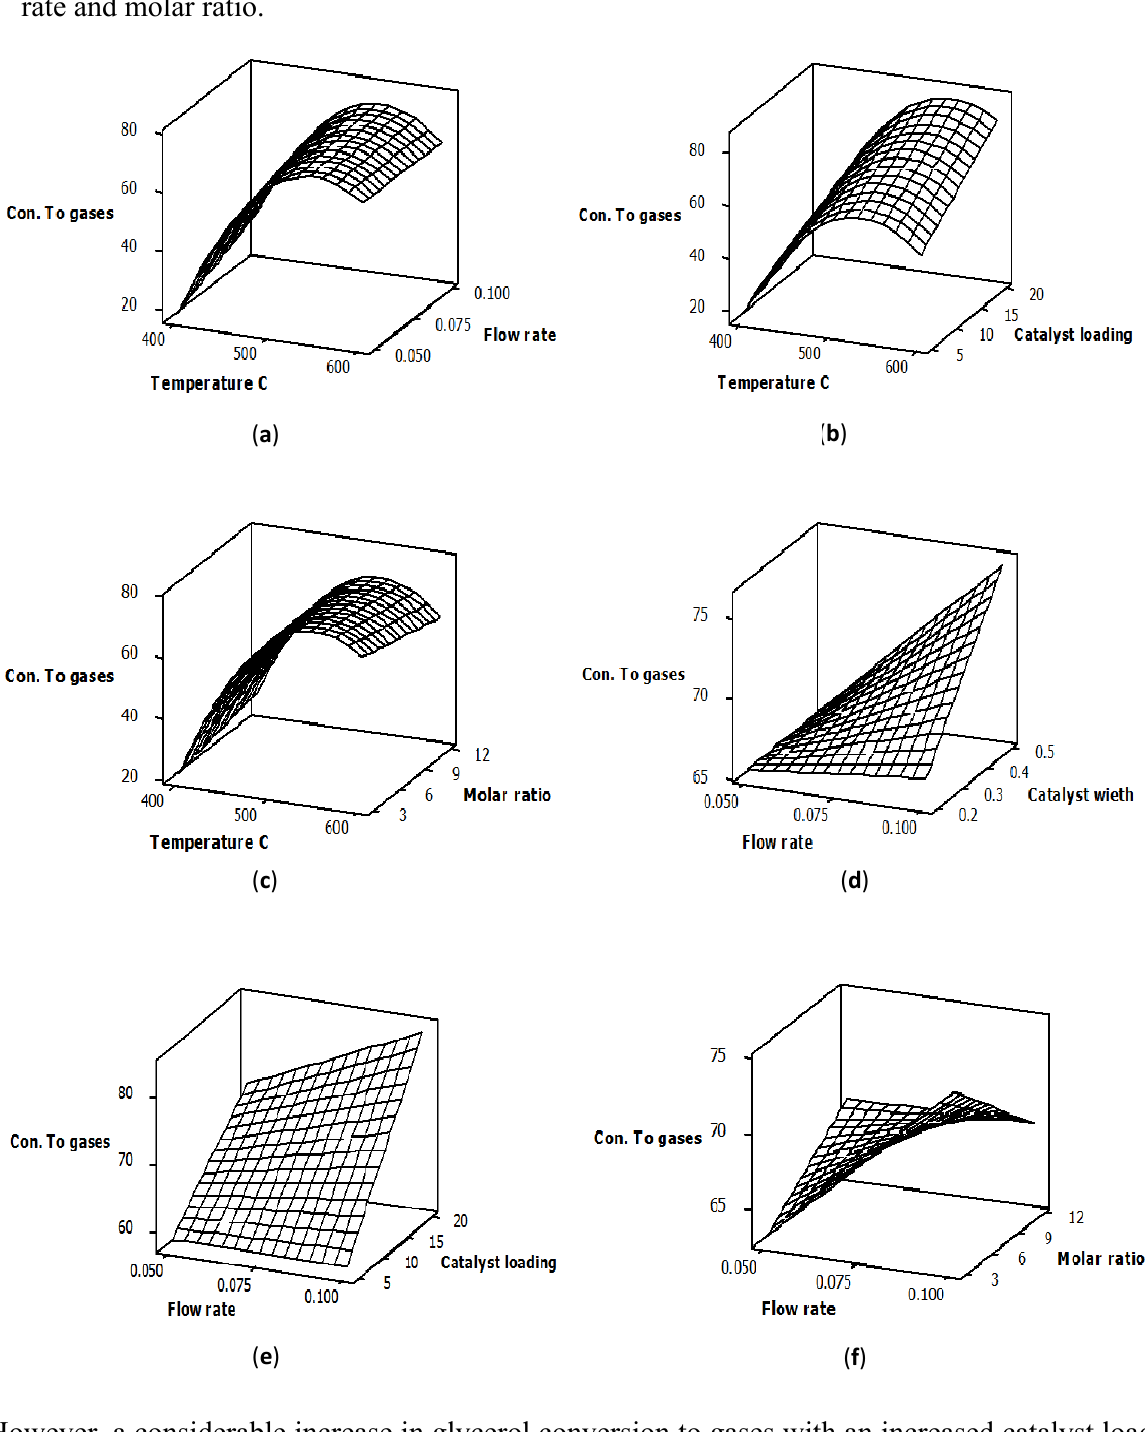
Figure 2. The interaction effects of process variables on glycerol conversion to gases: ( a ) temperature and flow rate; ( b ) temperature and catalyst loading; ( c ) temperature and molar ratio; ( d ) flow rate and catalyst weight; ( e ) flow rate and catalyst loading; ( f ) flow rate and molar